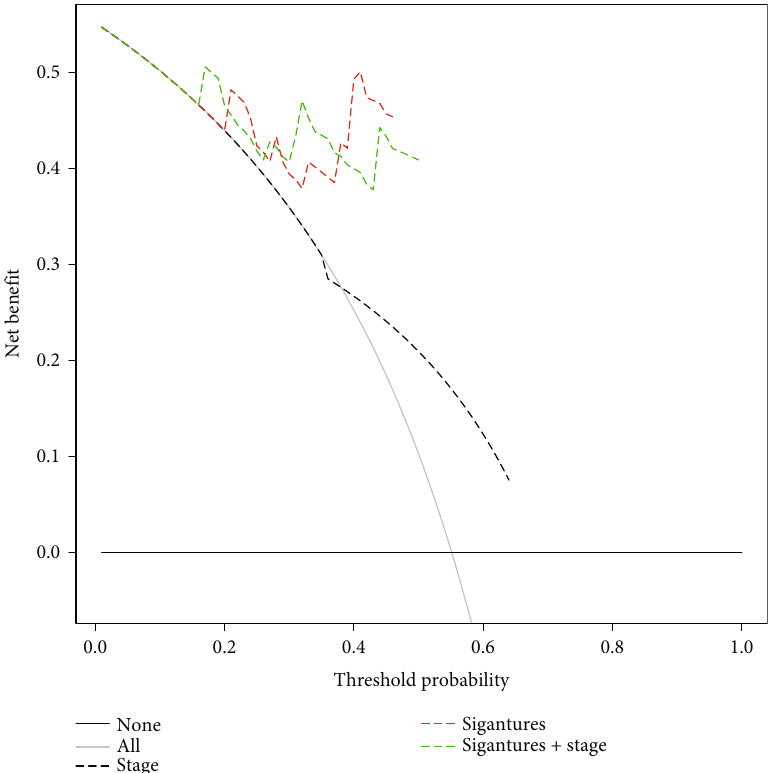
Figure 6: Decision curve analysis for each model in the validation cohort. The y -axis measures the net bene fi t. The net bene fi t was calculated by summing the bene fi ts (true-positive results) and subtracting the harms (false-positive results), weighting the latter by a factor related to the relative harm of an undetected metastasis compared with the harm of unnecessary treatment. The UMPS or the combined UMPS and AJCC TNM staging model had the higher net bene fi t compared with the AJCC TNM staging system in 10% threshold